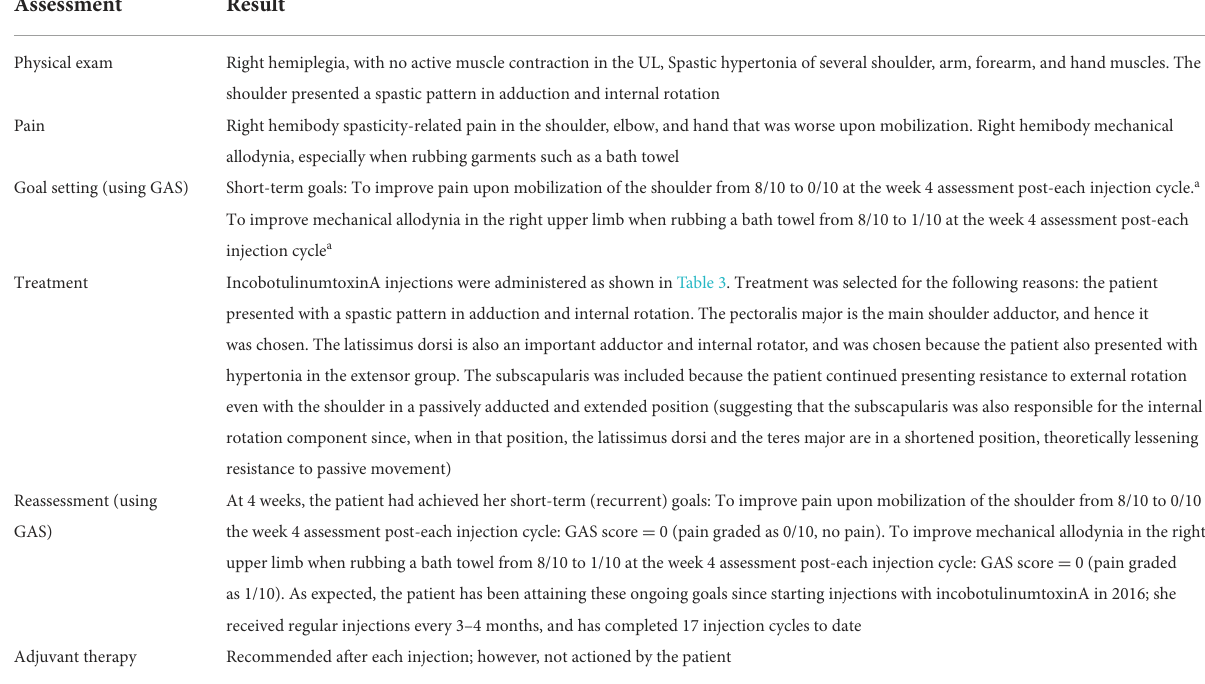
TABLE 2 Case 1: A 52-year-old female patient with prior history of arterial hypertension who experienced an ischemic stroke of the left cerebral hemisphere that caused a right spastic hemiplegia and was a candidate for botulinum toxin